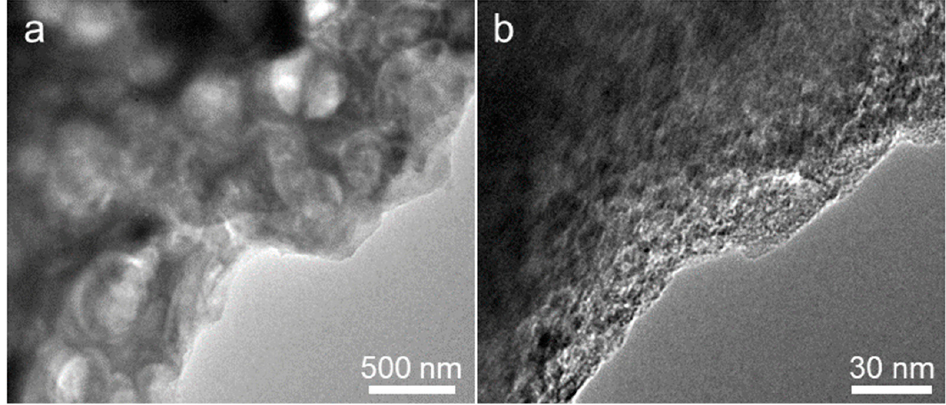
Figure 11. ( a ) Low and ( b ) high magnifications TEM images of Alg-C electrode after the 5000th cycle at a current density of 500 mA g − 1 .